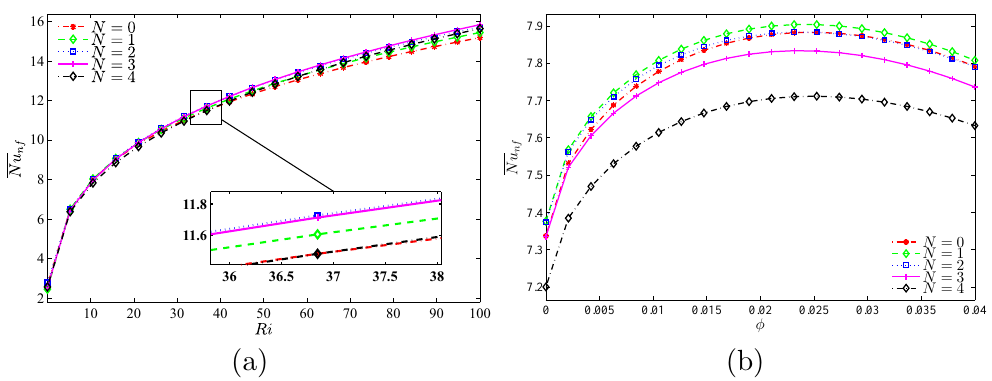
Figure 15. Variations of the average Nusselt number with ( a ) Ri and ( b ) φ for different N at Case 1 ( Ω ), R =